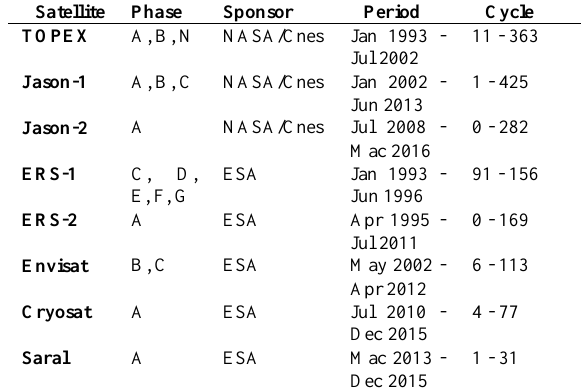
Table 1. Altimetry data selected for data verification